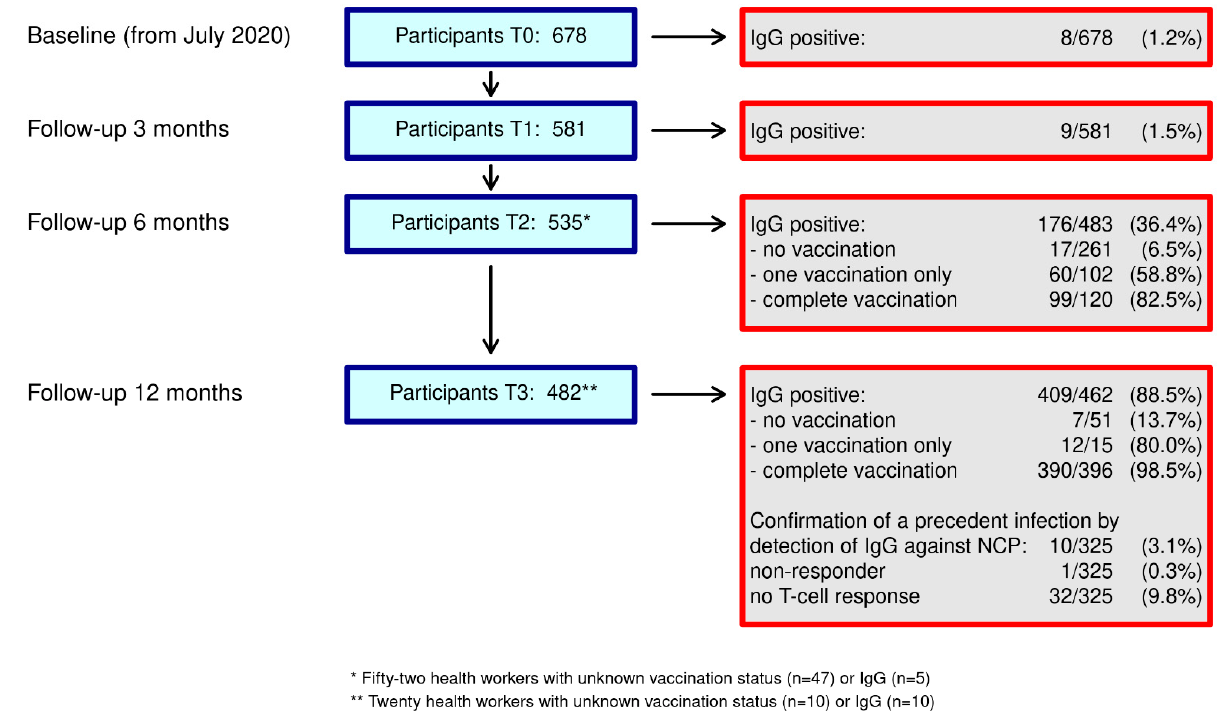
Figure 1. Flow chart of the number of participants involved in IgG seroprevalence investigations among outpatient care staff in Hamburg, longitudinally, over the study period from July 2020 to October 2021.